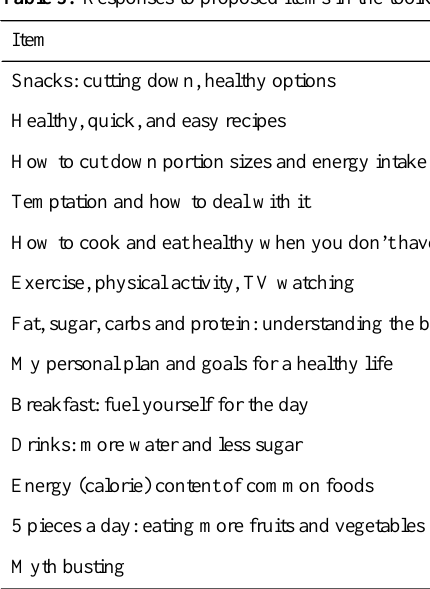
Table 3. Responses to proposed items in the toolkit (descending